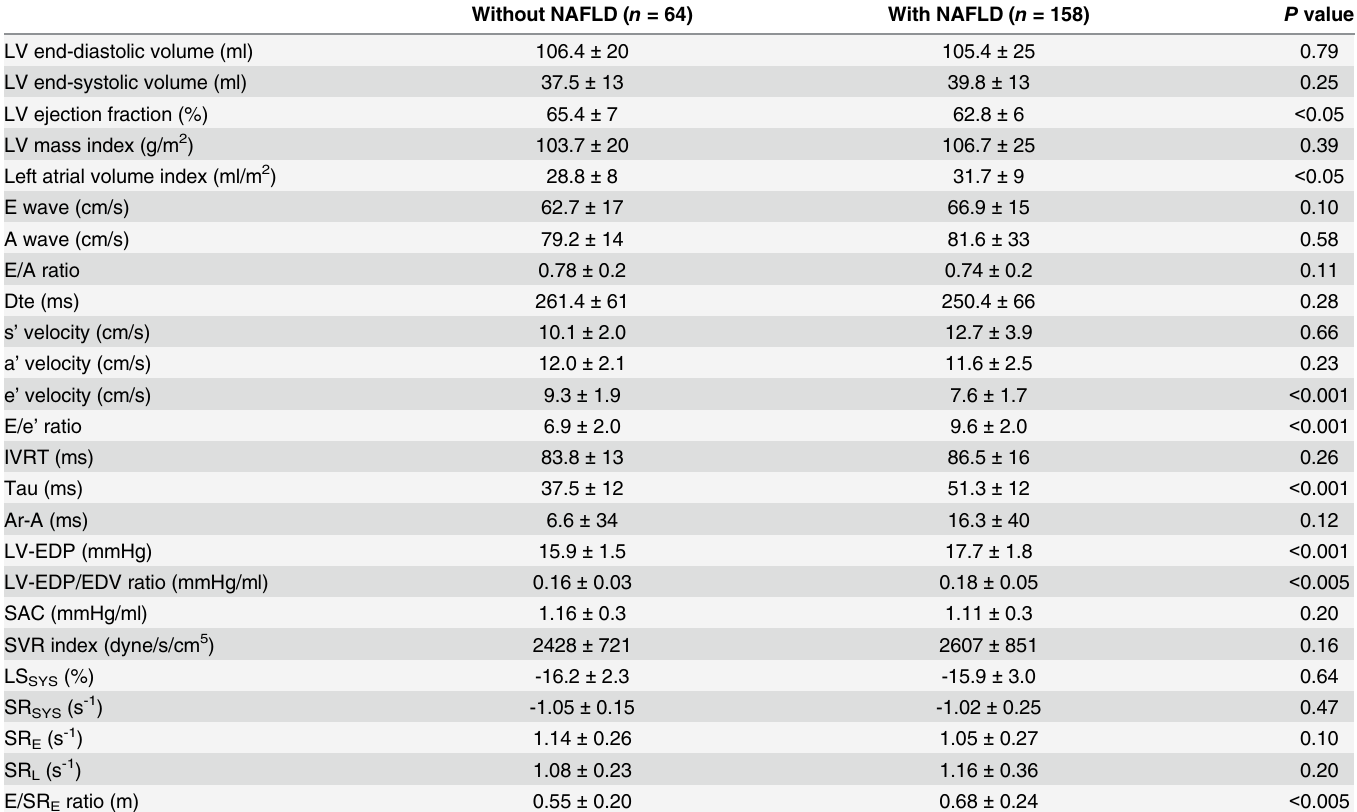
Table 2. Main echocardiographic characteristics of patients with type 2 diabetes stratified by presence or absence of NAFLD.